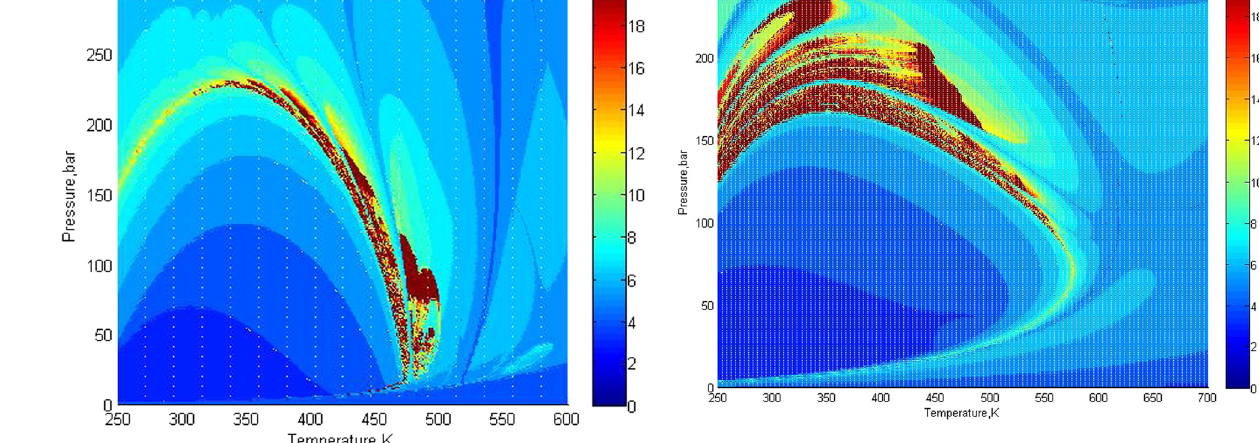
Figure 1: Number of iterations for the Y8 mixture, NBH method with type V initialization.